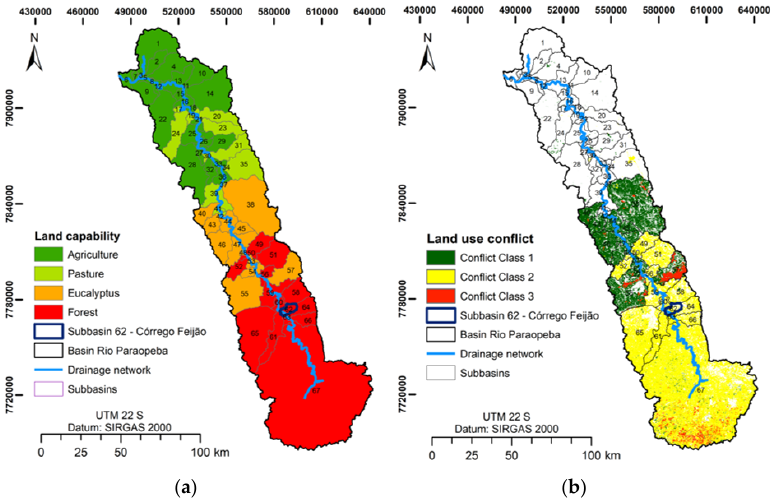
Figure 6. ( a ) Land capability classes; ( b ) land use con fl ict classes.